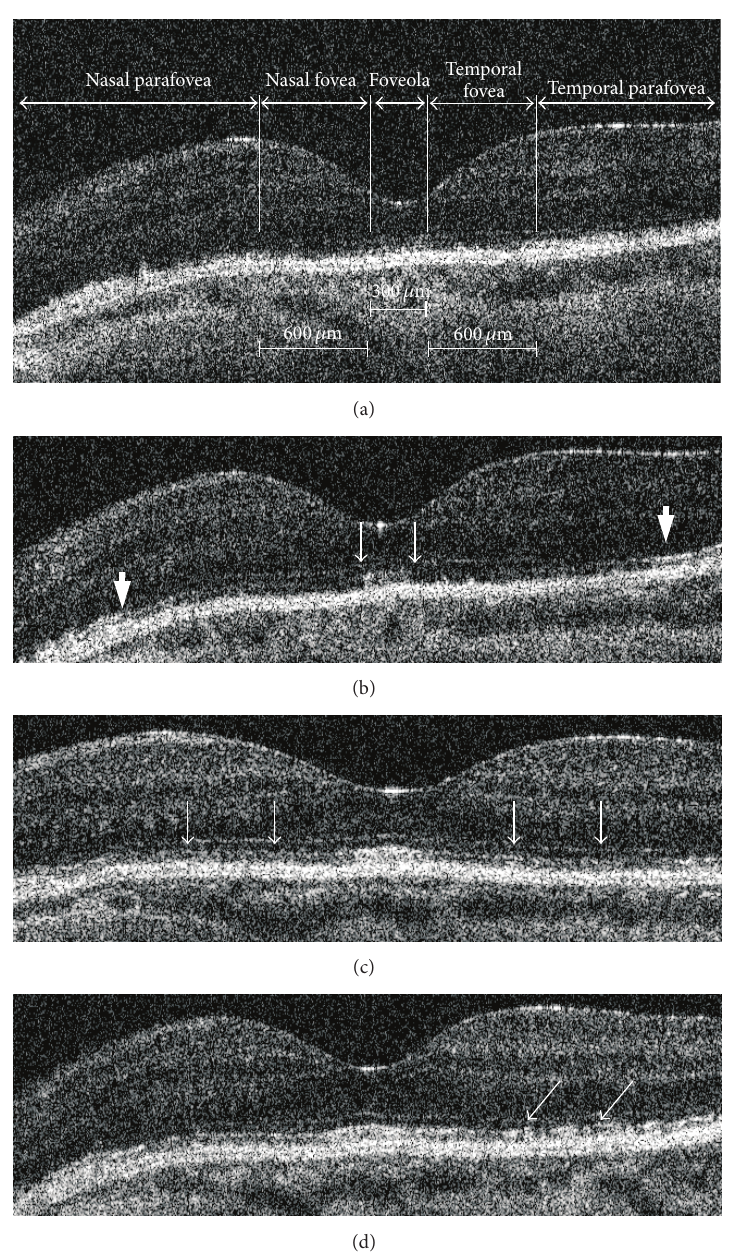
Figure 1: Restoration of normal IS/OS reflectivity after pars plana vitrectomy for macula-off rhegmatogenous retinal detachment in central SdOCTcrosssection. (a)Two weeks after surgerytheIS/OS lineisinvisiblein central partof thescan and hasreduced reflectivity inperiphery. (b) 10 weeks after surgery the IS/OS can be recognized in the entire scan and has reflectivity similar to normal one in foveola (thin arrows) and parafovea (thick arrows). (c) 44 weeks after surgery the IS/OS reflectivity increased in the area between foveola and parafovea (arrows). (d) 80 weeks after surgery only focal IS/OS disruptions can be observed